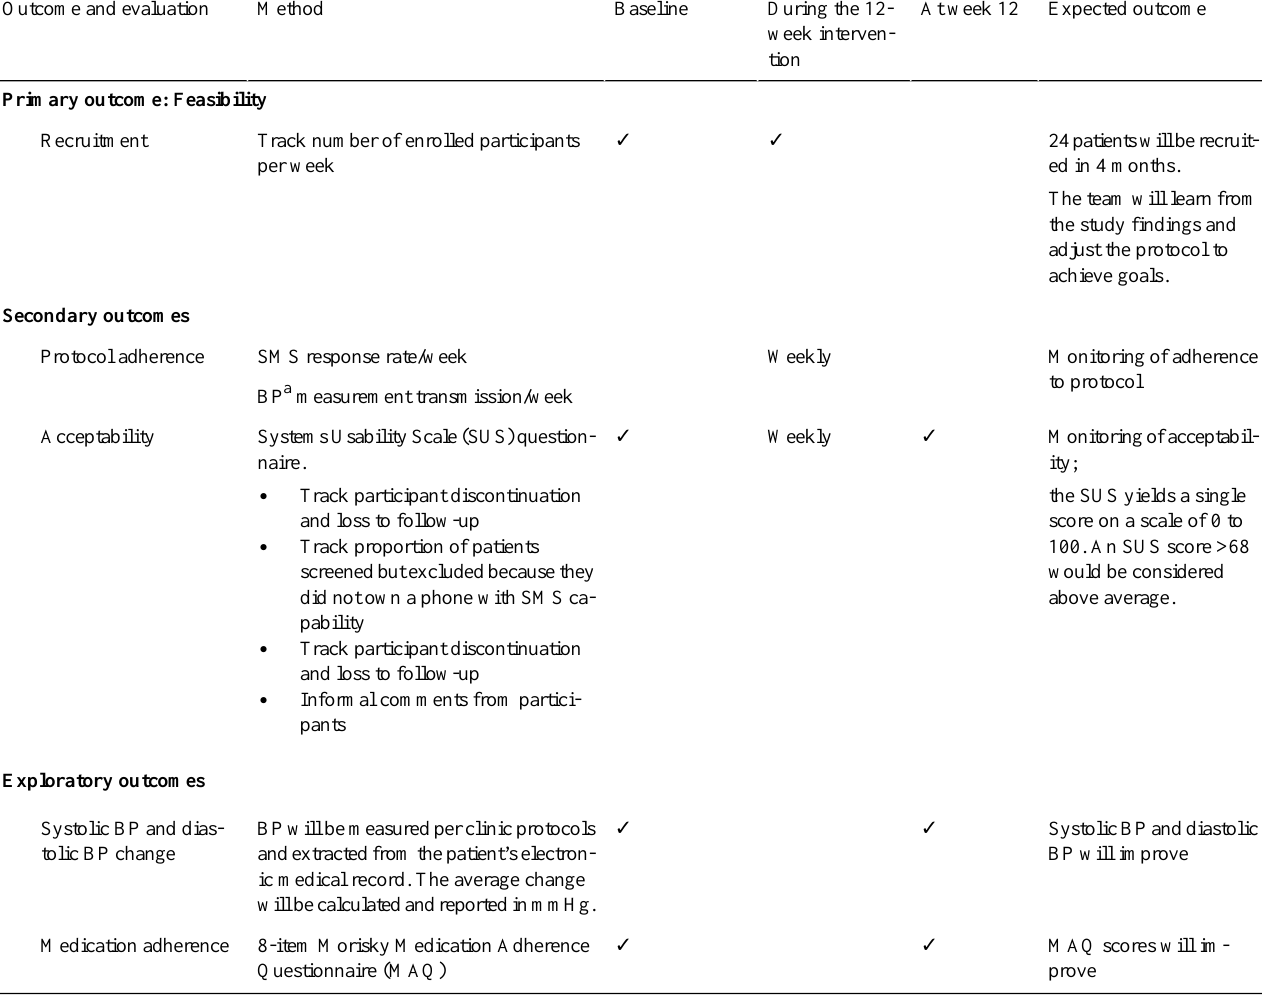
Expected outcomeAt week 12During the 12-